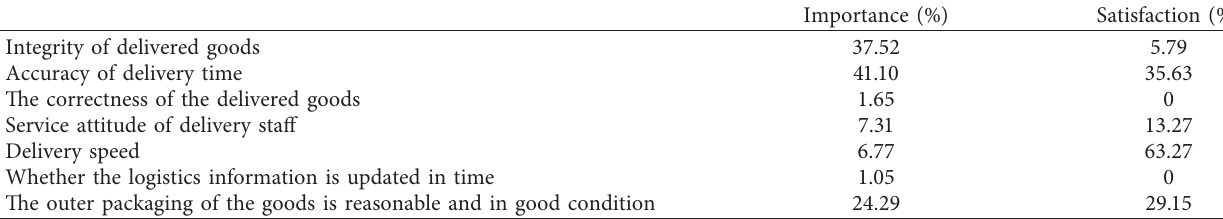
Table 8: Importance and satisfaction of factors affecting Taobao logistics service quality.